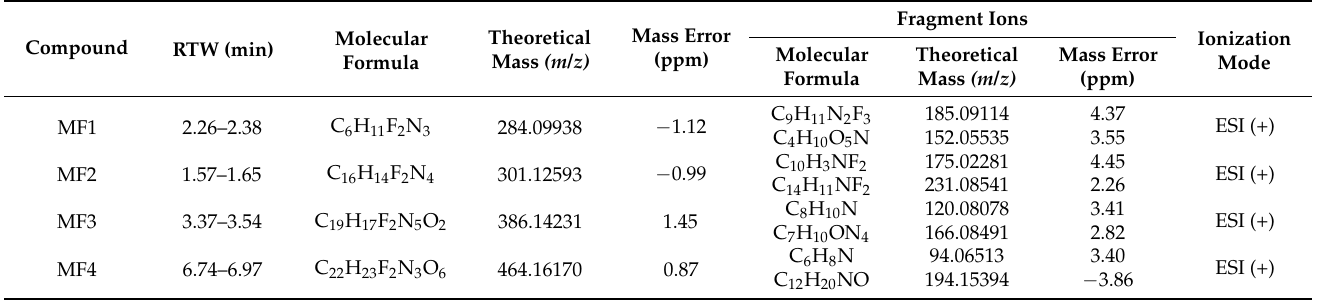
Table 3. Characteristic parameters for tentatively identified metabolites of flutriafol by unknown